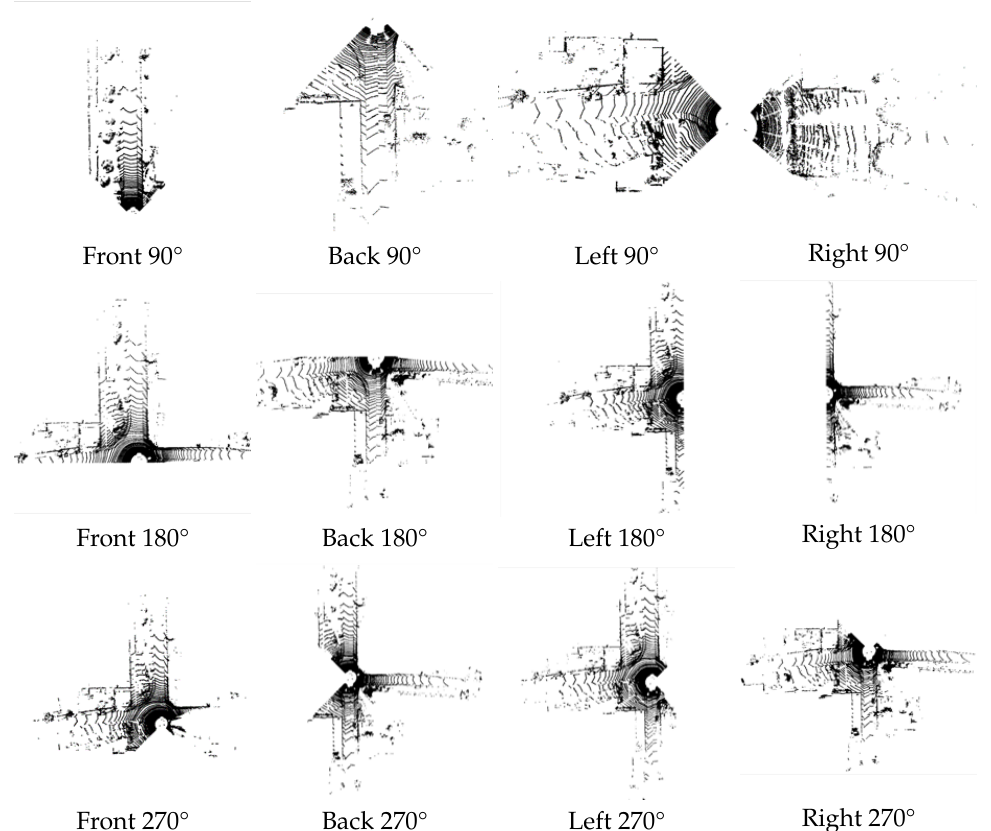
Figure 3. Simulation of the different fields of view of LiDAR. Voxel downsampling creates a 3D voxel grid (considering the voxel grid as a collection of spatial 3D cubes) from the input point cloud data [28–31]. Then within each voxel (3D cube), the other points in the voxel are approximated by the center of gravity of all points in the voxel, so that all points in the voxel are represented by one center-of-gravity point. Voxel downsampling creates a 3D voxel grid (considering the voxel grid as a collection of spatial 3D cubes) from the input point cloud data. Then within each voxel (3D cube), all points in the voxel are approximated using the voxel’s center of gravity to reveal other points in the voxel so that all points in the voxel are represented by a single center of gravity point. As a result, the number of points is reduced, the matching speed is improved, the shape features of the point cloud remain basically unchanged, and the spatial structure information is preserved. The larger the voxel grid selection, the smaller the sampled point cloud, and the faster the processing speed; however, the original point cloud will be too blurred. A smaller voxel grid selection will have the opposite effect. At the same time, it is necessary to record the number of points of the different LiDAR point cloud data after desampling, as shown in Figure